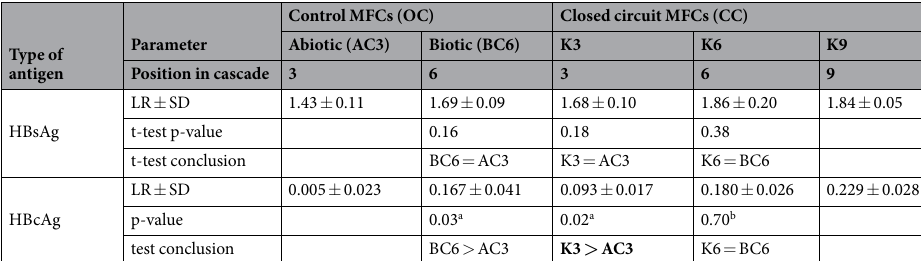
Table 1. Log reduction (LR) of surface and core antigens in MFC cascade system and the results of statistical significance of the difference between LR average values. * LR – Log Reduction, SD – Standard deviation, a results of t-test, b results of Wilcoxon-Matt-Whitney test.